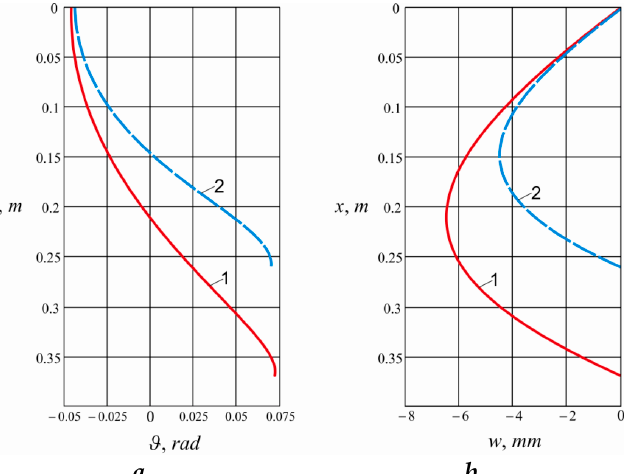
Figure 6. Distribution of displacements along an intact fibula: ( a ) rotation angles of cross-sections; ( b ) bone deflections; 1—the tightrope tightening force for a tall person is P = 160 N; 2—the tightrope tightening force for a small person is P = 75 N.